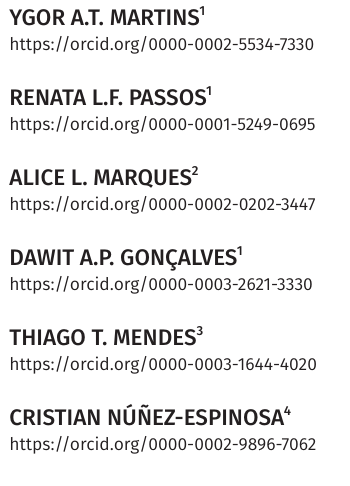
Figure S1. Regression line of the curves concerning core temperature x exercise time points during the heat protocol, in the pre-Antarctic and post-Antarctic situations. The conditions of uncompensable heat stress were confirmed by calculating the Pearson’s correlation coefficient and plotting the regression line of the curves concerning core temperature x exercise time points; the R-value corresponded to 0.97 for both the pre- and post-Antarctica situations (n =